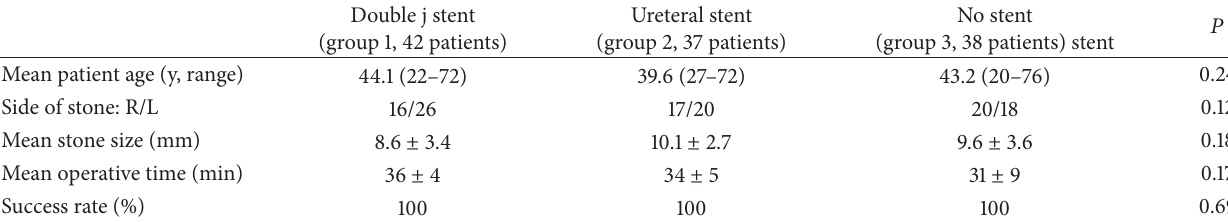
Table 1: Patient’s characteristics and